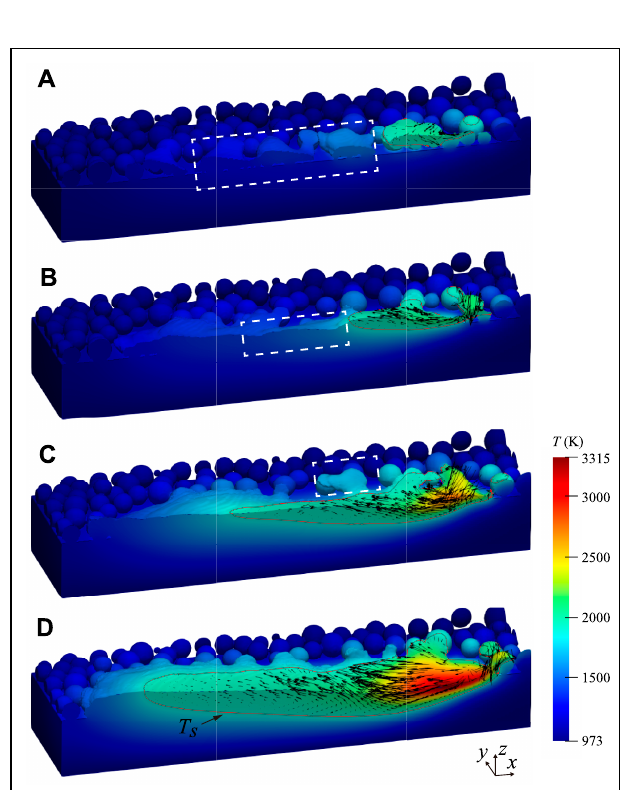
FIGURE 6 | The morphological characteristics and temperature distribution of the melt pool with an increase of the electron beam current in the longitude cross section view (A) : I B = 1.0 mA, (B) : I B = 1.5 mA, (C) : I B = 2.5 mA, (D) : I B = 4.0 mA). The dash squares mark the morphological features (A) : the balling effect, (B) : the fluctuation of the solidified track, (C) : the partially melted